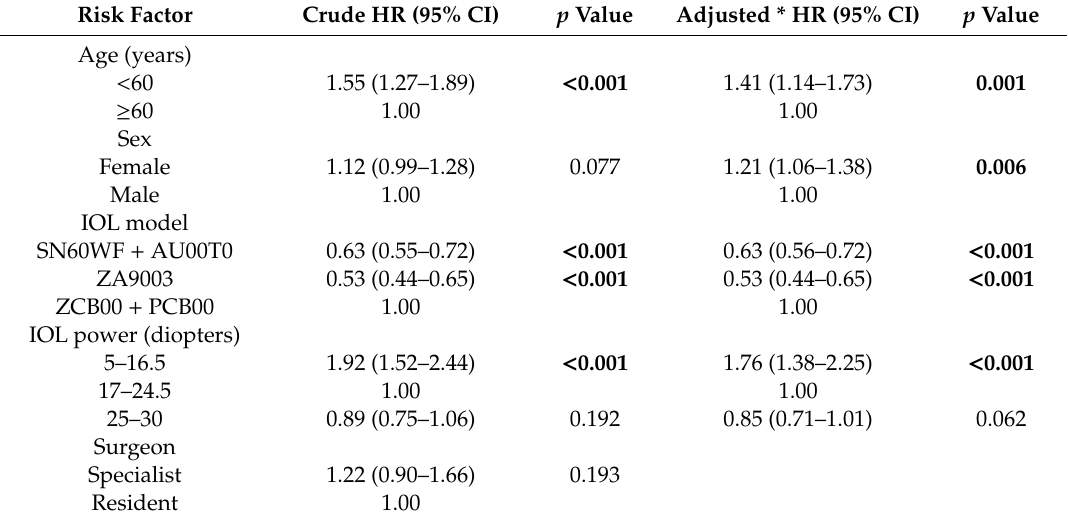
Table 2. Crude and adjusted Cox regression analysis of potential risk factors associated with Nd:YAG